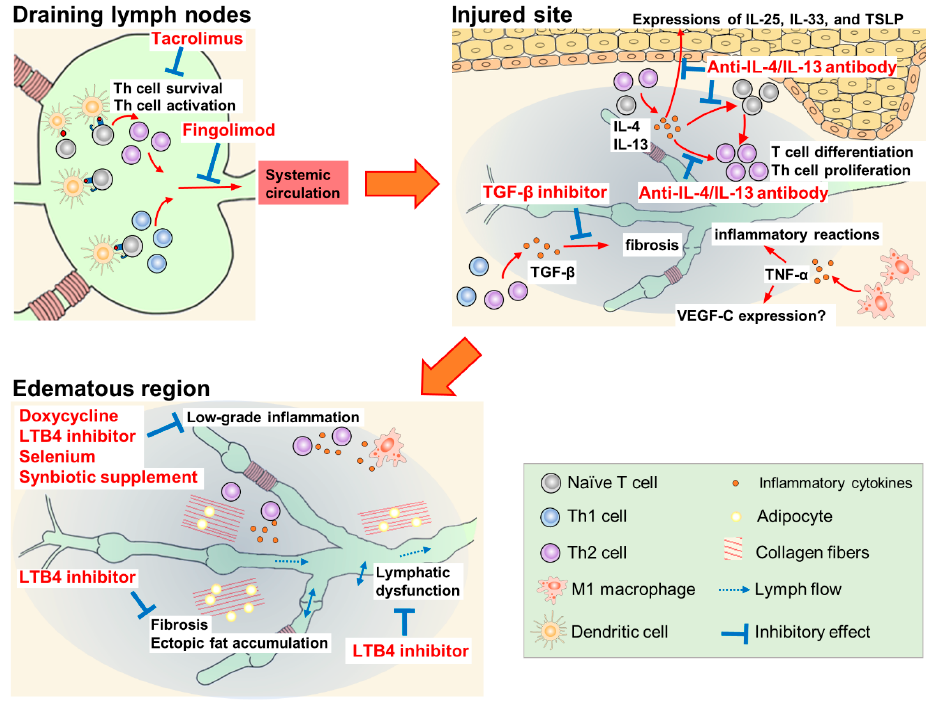
Figure 2. Pharmacological mechanisms of therapeutic agents for lymphedema.